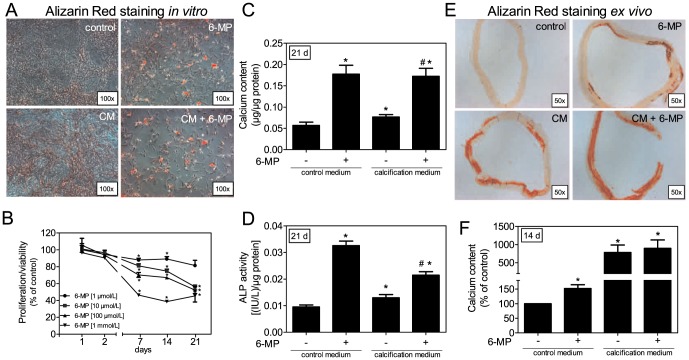
6-MP-induced calcification in vitro and ex vivo.(A–D) VSMCs were cultured in control medium or CM±6-MP (100 µmol/L) for 21 days. (A) Mineral deposits were visualized via Alizarin red staining. One representative experiment is shown (n = 5). (B) VSMCs were treated with 6-MP (1 µmol/L–1 mmol/L) for up to 21 days and viability/proliferation was measured. (C) Calcium content (n>6) or (D) ALP enzyme activity (n>6) was quantified and normalized to protein content. (E,F) Rat aortic rings were incubated in control medium or CM ± 6-MP (100 µmol/L) for 14 days. (E) One aortic ring treated with each type of stimulation was used for histochemical analysis. Slices were stained with Alizarin Red to visualize calcium deposition. (F) Calcium content was quantified and normalized to the dry weight of aortic rings (n>6). Data represent means±SEM, *p<0.05 vs. control. #p<0.05 vs. CM. ALP: alkaline phosphatase, CM: calcifying medium, 6-MP: 6-mercaptopurine.